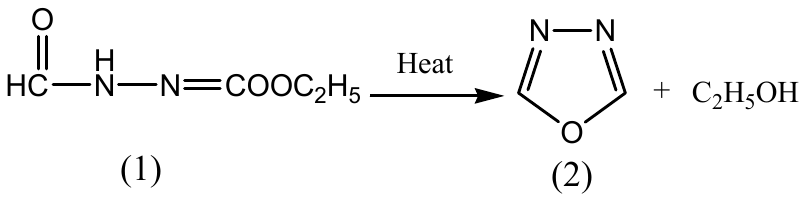
Table 1. Bond angle and bond length of 1,3,4-oxadiazole moiety.